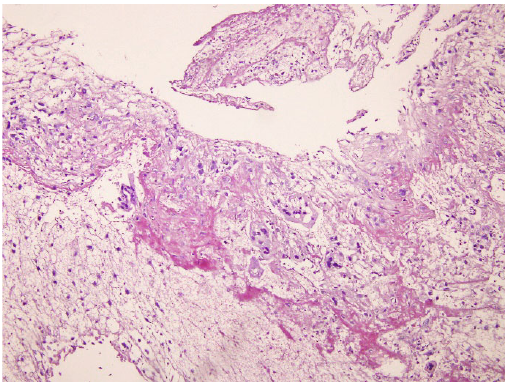
Figure 5: Histopathological view of the right ovarian tissue showing the chorionic